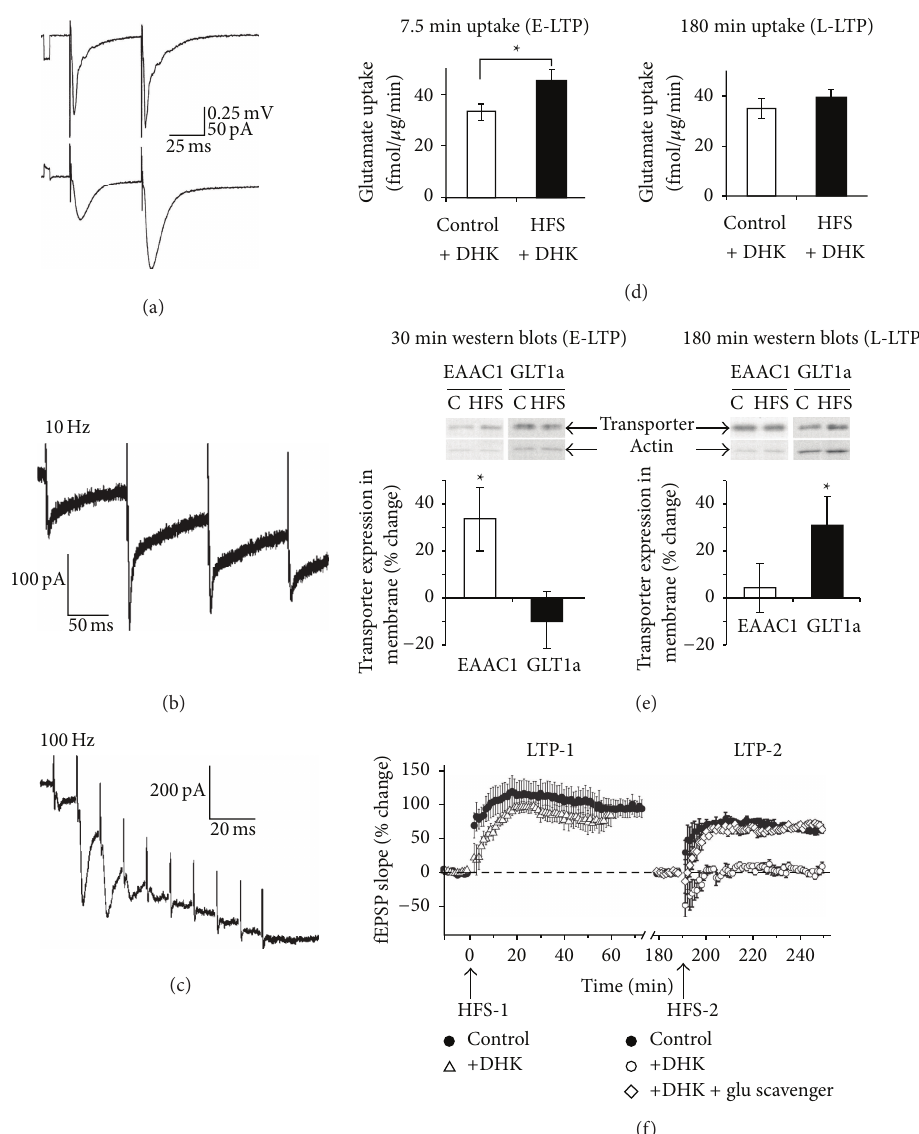
Figure 4: Short- and long-term plasticity of astroglial glutamate uptake. (a) Simultaneous recordings of neuronal responses (fEPSPs; field excitatory postsynaptic potentials) and astroglial glutamate transporter currents (STCs) revealed paired-pulse facilitation of both fEPSPs and astroglial glutamate uptake in hippocampal CA1 region. Sample traces are shown for fEPSPs (top) and astroglial STCs (bottom). STCs were recorded in the presence of 5 mM kynurenic acid. Scale bars = 0.25 mV for fEPSP, 50 pA for astroglial currents, 25 ms. (b-c) Patch-clamp recordings revealed short-term facilitation of astroglial extrasynaptic currents (ESCs) in the cerebellum. Sample traces are shown for ESCs in response to 10 pulses of (b) 10 Hz or (c) 100Hz stimulation to parallel fibers. (d-e) Astroglial GLT-1 glutamate transporter is responsible for glutamate uptake during late but not early phase of long-term potentiation (LTP) in the hippocampus. (d) Bar graphs showing that the GLT-1 inhibitor, dihydrokainate (DHK), inhibited glutamate uptake during late phase (L-LTP; right panel), but not early phase (E-LTP; left panel) of LTP induced by high frequency stimulation of SCs (HFS; each composed of two trains of 100Hz pulses separated by 20 s). Glutamate uptake in hippocampal slices were measured using radioactive glutamate (L-[14C(U)]-glutamic acid). (e) Western blot analysis revealed a significant upregulation of neuronal glutamate transporter (EAAC1) expression during E-LTP (left panel) and of GLT-1 during L-LTP (right panel). Representative western blots are shown above bar graphs. (f) Recordings of fEPSPs in hippocampal CA1 region showed that an increase in GLT-1 activity and glutamate uptake are required for the induction of additional LTP. LTP was triggered twice in the same experiment (LTP-1 and LTP-2). Each LTP was induced by HFS as indicated by arrows (HFS-1 and HFS-2). During LTP-1, no difference was observed between slices treated with DHK (open triangles) and control (filled circles) indicating that basal GLT-1 activity was not required for induction of LTP-1. After the establishment of a new baseline, an additional LTP (LTP-2) was triggered under control conditions (filled circles). This was completely inhibited in slices treated with DHK (open circles). The effect of DHK was abolished in the presence of a glutamate scavenger (glutamic-pyruvic transaminase + pyruvate). These suggested that an increase in GLT-1 activity above basal level and the accompanying enhanced glutamate uptake is important for the induction of LTP-2. Mean ± SEM are shown for (d–f). Adapted with permission: (a) [12], (b-c) [10], (d-e) [19], and (f)